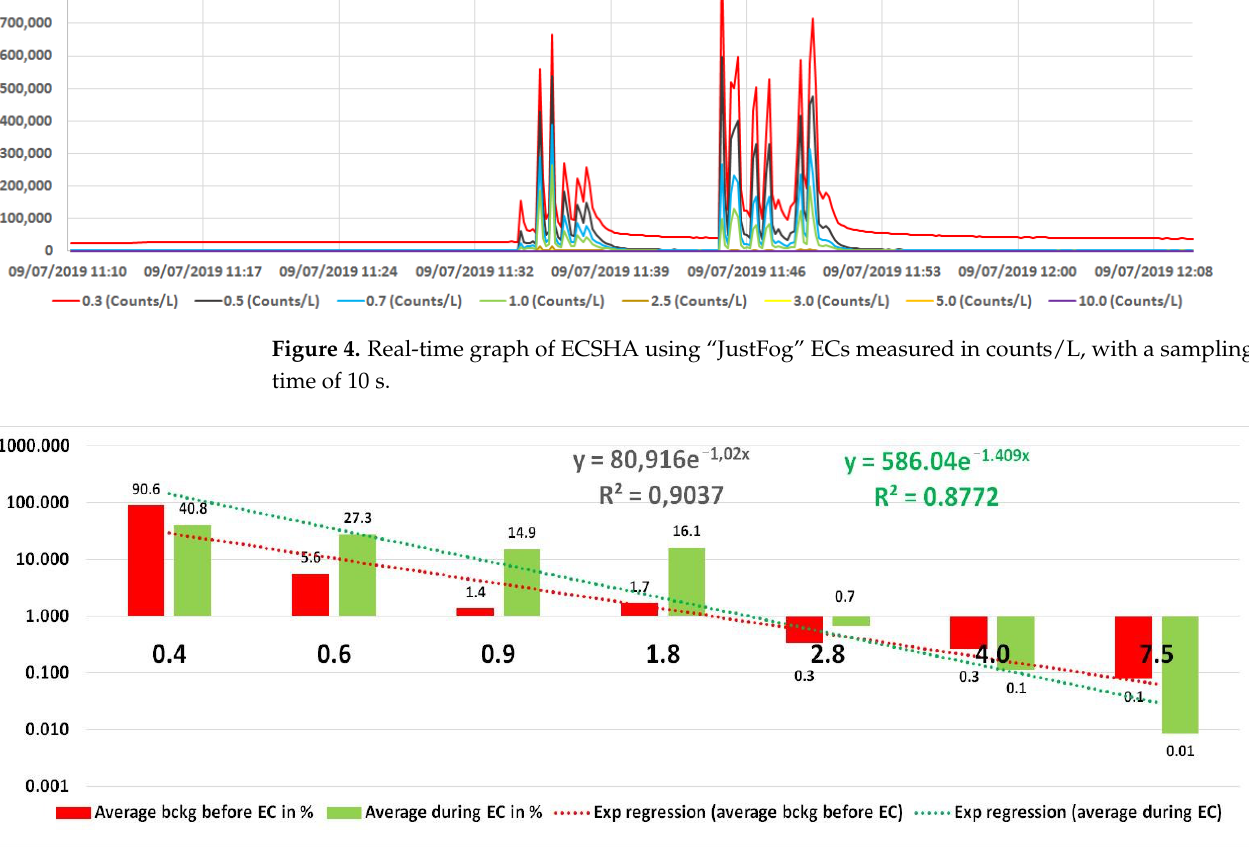
Table 4. Details of ECSHA measured in counts/L with Profiler 212-2 when using “JUUL” ECs.